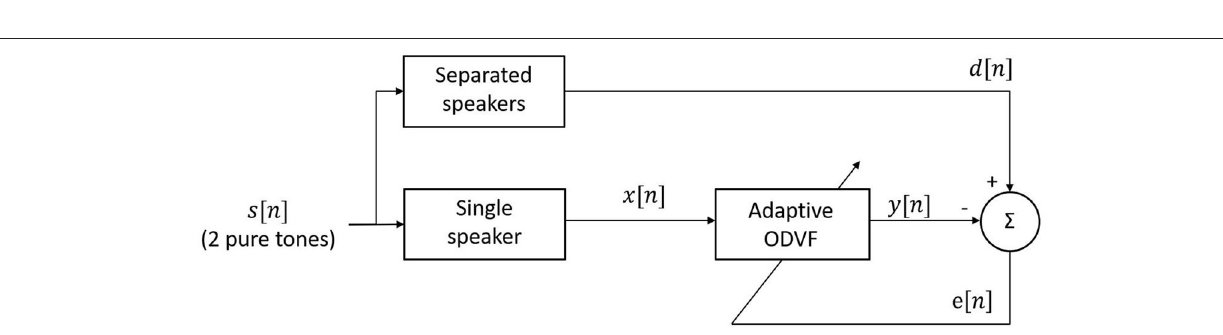
FIGURE 6 | Block diagram for computing the ODVF coefficients.